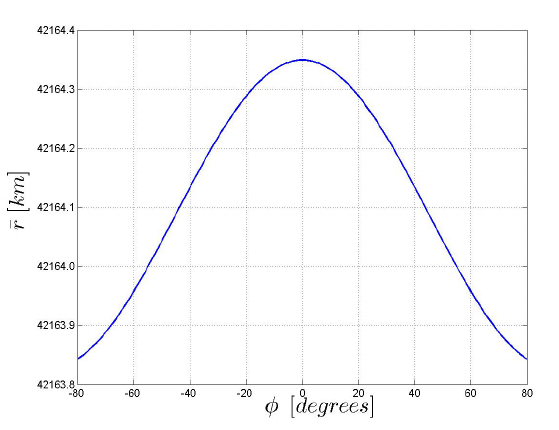
Figure 5: The mean radius (¯ r ) of a geosynchronous satellite along parallel circles at latitude ϕ .